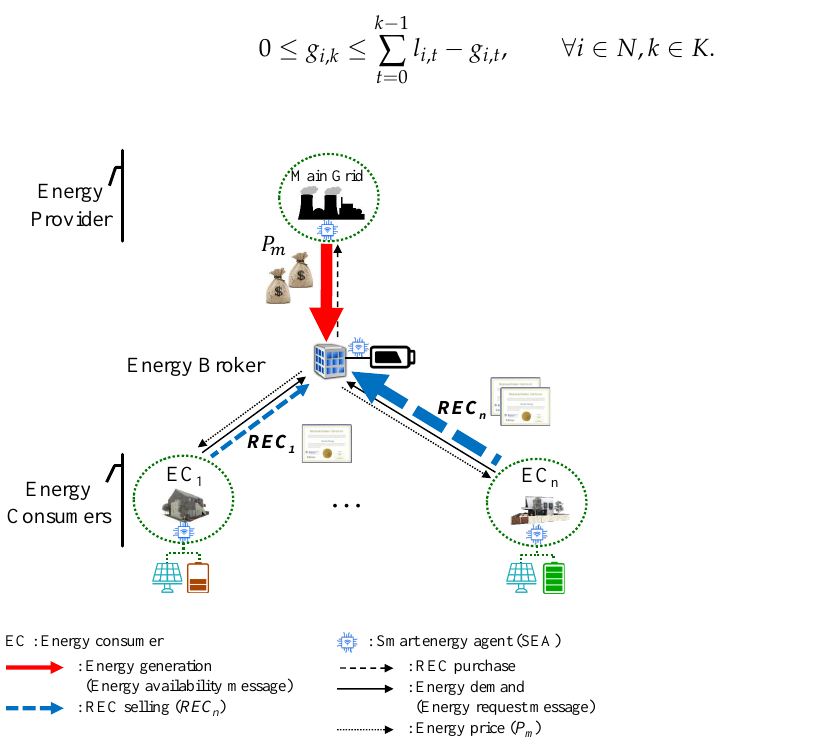
Figure 1. System model of proposed demand-based trading mechanism in an energy broker with dynamic